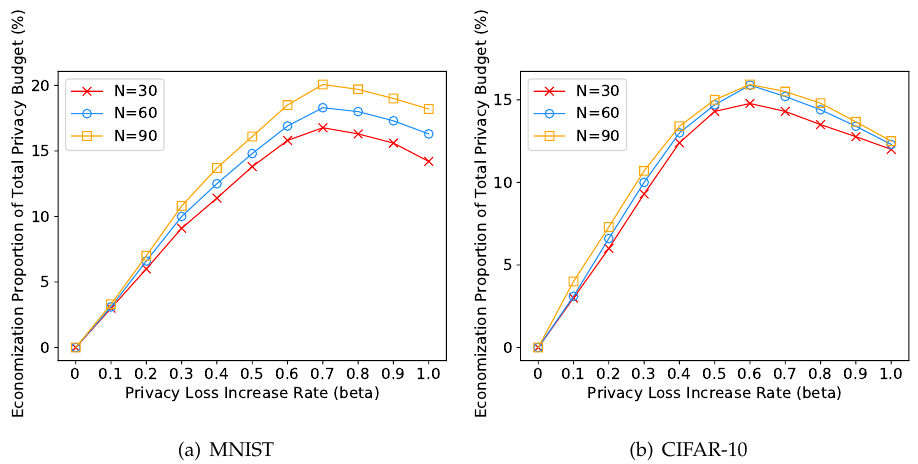
Figure 8. The economization proportion of total privacy budgets with different privacy loss increase rates for 30, 60, and 90 participants respectively under